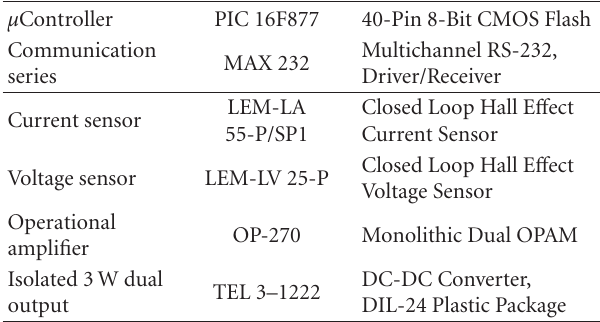
Table 3: Electrical characteristics of the components used for the SEPIC Converter.